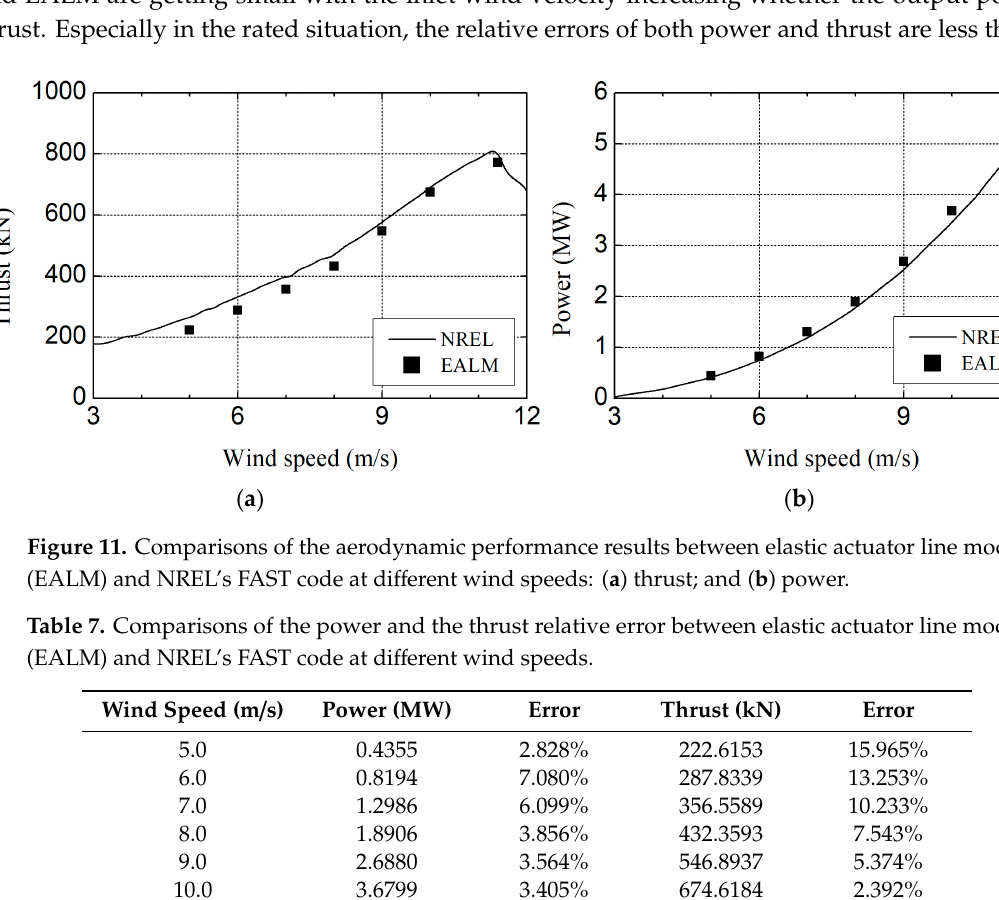
13 of 24 Figure 10. Comparison of different cases results in 11.4 m/s: ( a ) power; and ( b ) thrust Case 1: Elastic Actuator Line Model (present study); Case 2: NREL’s FAST code; Case 3: Horizontal Axis Wind turbine simulation Code 2nd generation results; Case4: research by Li et al. [17]; Case 5: research by Jeong et al. [30]; Case 6: research by Ponta et al. [31]; Case 7: research by Yu et al. [32,33]; Case 8: research by Ma et al. [13]. To further examine the accuracy of EALM under different wind speed conditions, power and thrust are computed and compared with Case 2, which are shown in Figure 11. Besides, their relative errors are given in Table 7. The errors are smaller when the wind speed is close to the rated speed, which is 11.4 m/s, than those when the wind speed is below 8 m/s. This phenomenon is caused by the coefficients of lift and drag l C and d C